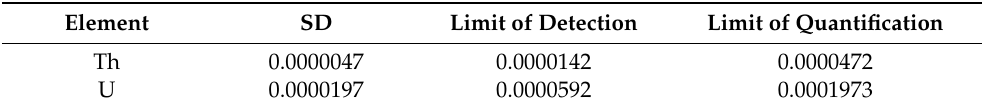
Table 5. Standard deviation of parallel test Th, U and detection limit and quantification limit of test elements (g · L − 1 ).